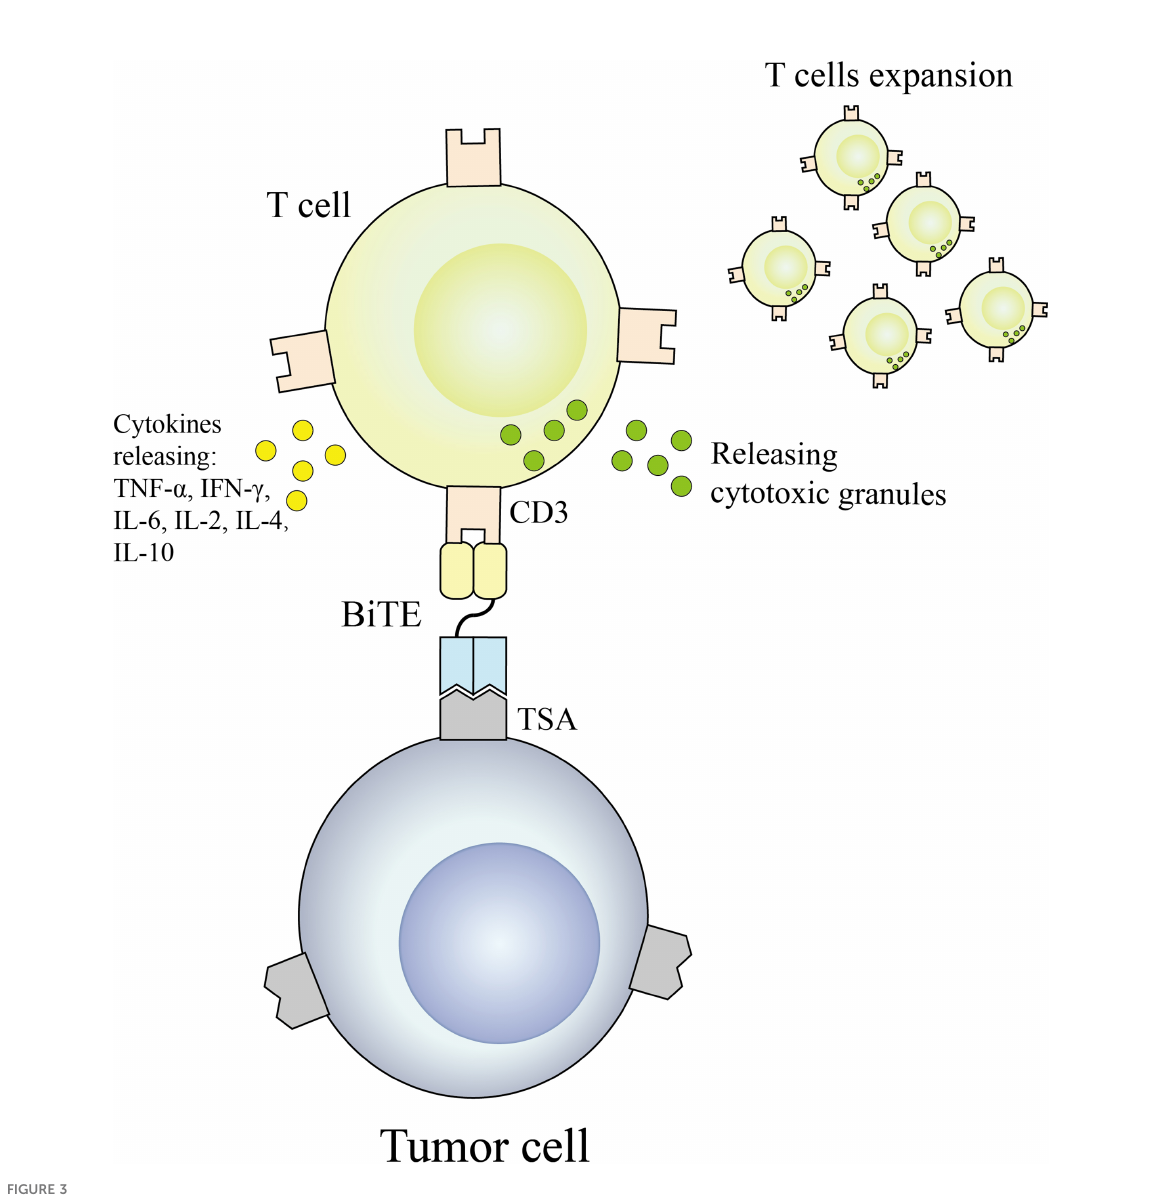
FIGURE 3 BiTE antibodies redirect T cells to a tumor